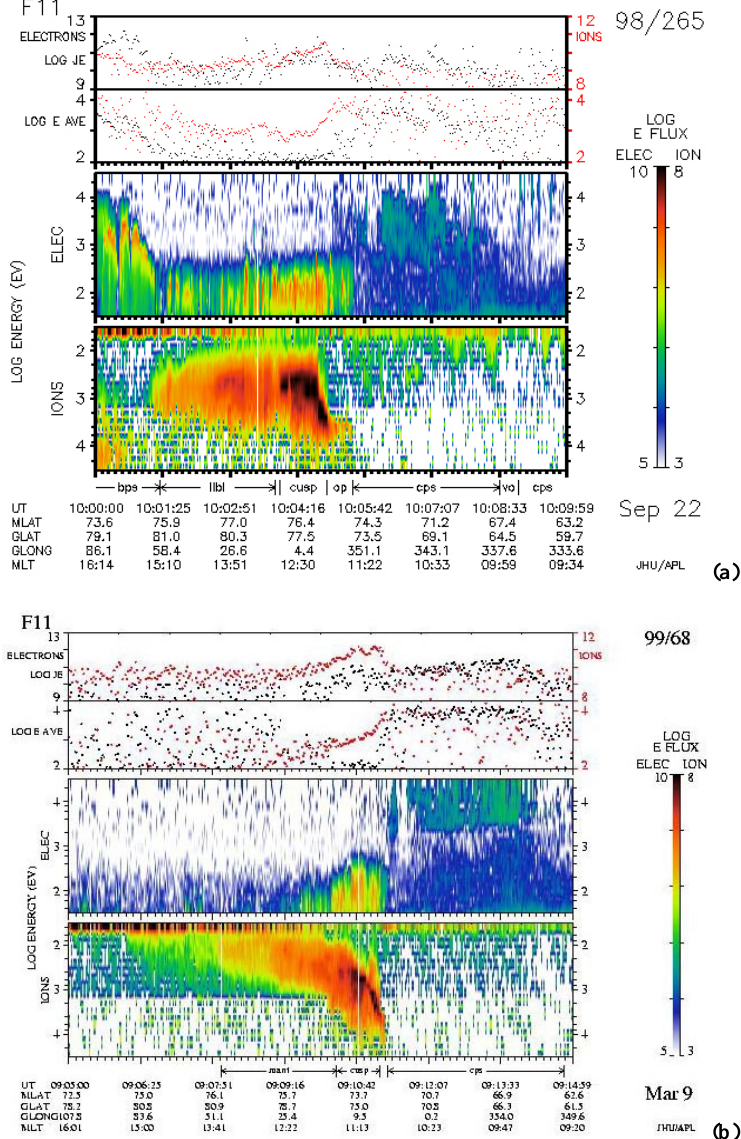
Fig. 2. DMSP F11 spectrograms of differential energy flux (eV/cm 2 sstr). Top two line plots show total energy flux (eV/cm 2 sstr) and average energy (eV) of ions (red) and electrons (black). Cusp particle precipitation was observed at the time of (a) 10:03–10:04UT on